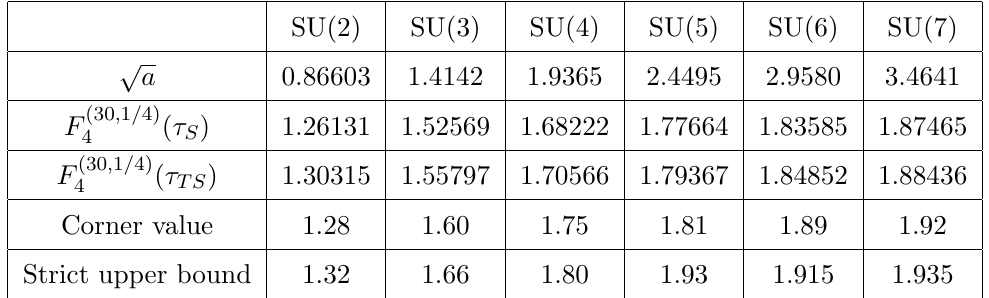
Table 3 . The interpolating function for spin-2 at the duality invariant points and data from the N = 4 superconformal bootstrap.